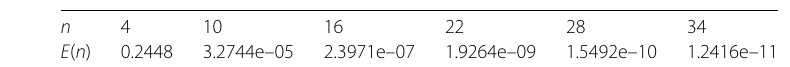
Table 1 E ( n ) = 6 n + 4, n =